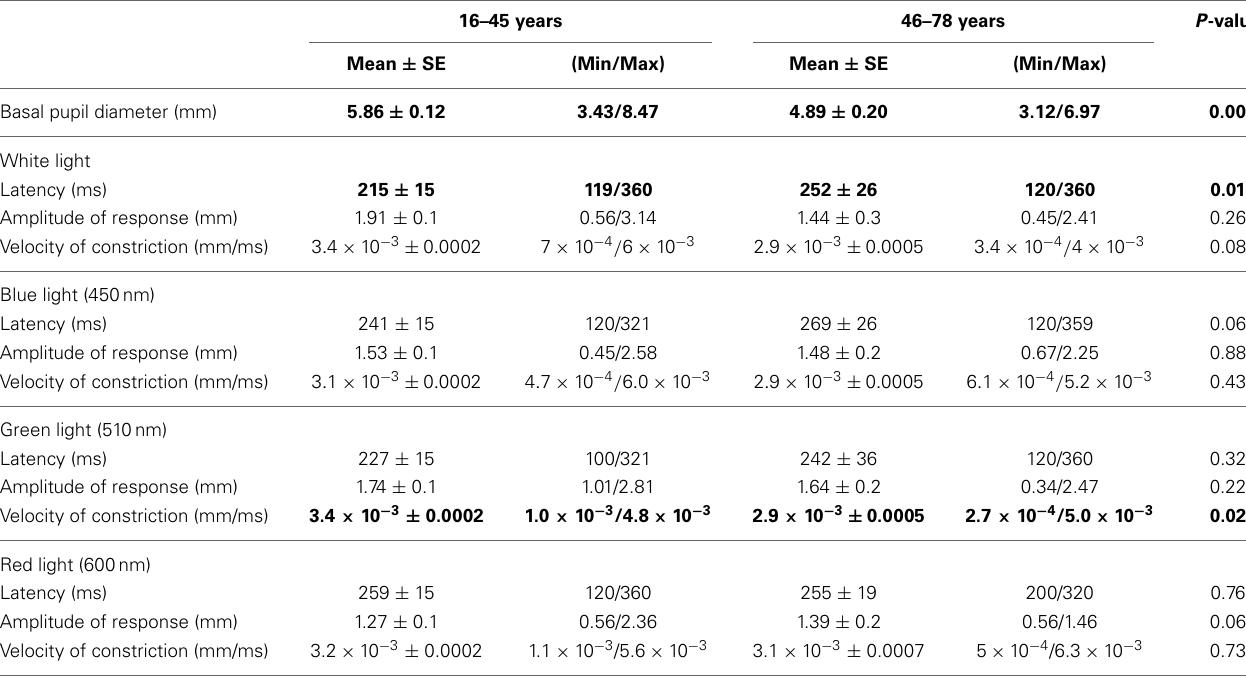
Table 1 | Values for all pupillary parameters obtained with the four study-light divided by